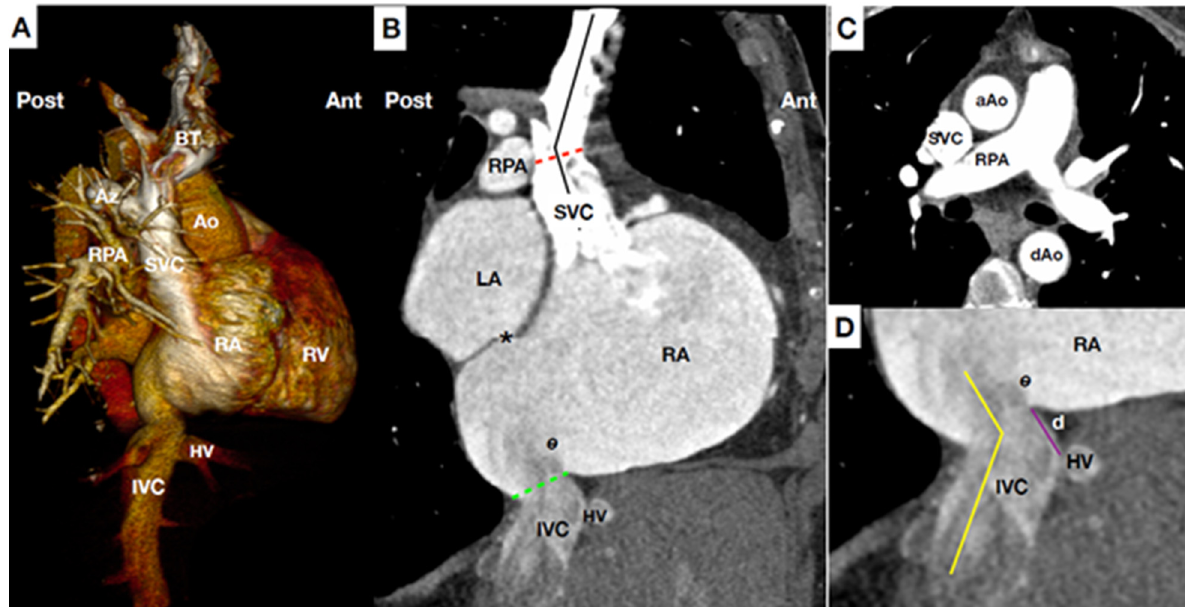
Figure 1. Main anatomical landmarks for CAVI. ( A ) Computed tomography (CT) scan reconstruction of central venous system, right heart and pulmonary artery at lateral plane. ( B ) CT para-sagittal plane at the level of the vena cava. Superior vena cava (SVC) is usually 7.1 cm long, and has slight angulation (black line), usually at the level of right pulmonary artery (RPA) (Red line). Of note, the junction of SVC-right atrium (RA) and junction IVC-RA are not in the same anterior-posterior plane. Special caution applies to patients with short distance between the IVC-RA junction (green line) and inter-atrial-septum (*) owing to the risk of septal perforation during inferior caval prosthesis delivery. Eustachian valve (e) varies in size, may be very prominent. ( C ) CT transversal plain at the level of RPA. Notable structures (i.e., aorta, trachea, pulmonary artery, etc) are adjacent but not attached to SVC minimizing risk of complications during CAVI. ( D ) CT at para-sagittal plane of the IVC-RA junction showing the distance between hepatic vein (HV) confluence and IVC-RA junction (purple line). Higher distance at this level helps to stabilize the devices owing that it increases the contact surface between device-vein wall. The IVC-RA junction (yellow line) usually presents with a greater angulation than SVC-RA junction. Ao: Aorta. AZ: Azygos vein. BT: Brachiocephalic trunks (Innominate). dAo: descending Aorta. d.: distance between hepatic vein confluence and inferior vena cava-right atrium junction. HV: Hepatic veins. IVC: Inferior vena cava. LA: Left atrium. RA: Right atrium. RPA: Right pulmonary artery. RV: Right ventricle. SVC: Superior vena cava.